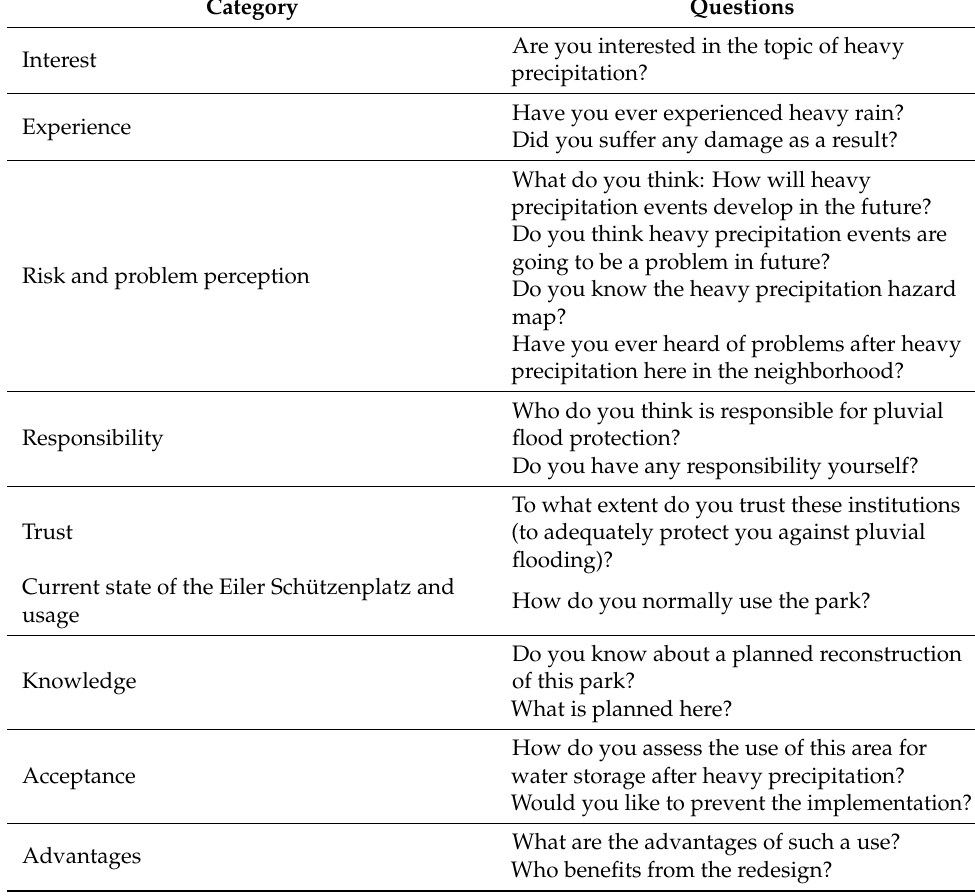
Table A1. Translated interview